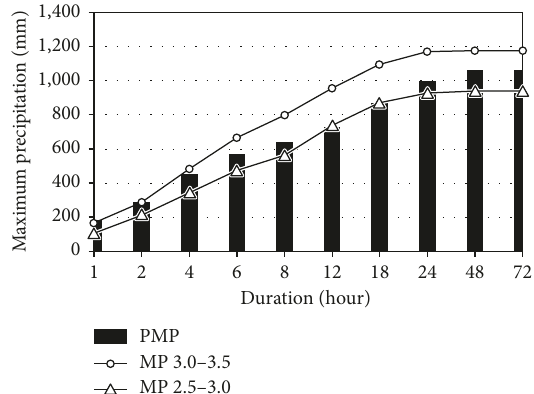
Figure 9: Comparison of PMP and selected MPs.